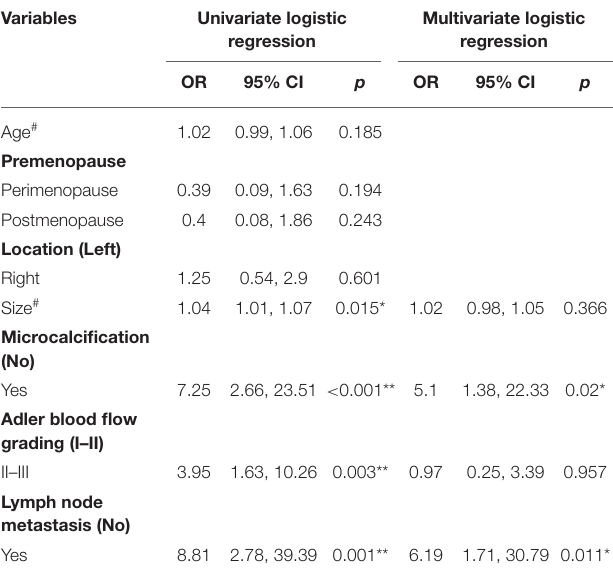
TABLE 2 | Univariate and multivariate logistics regression analysis with US-related variables.